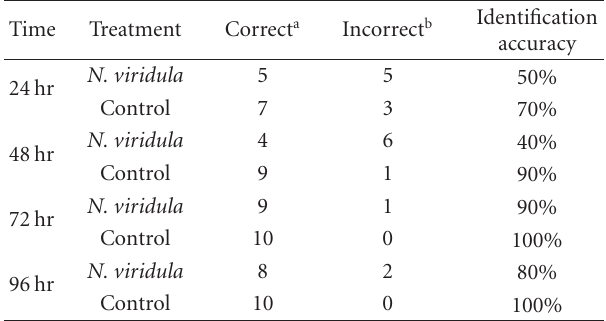
Table 3: Accuracy of E-nose training sets used to identify 10 unexposed bolls (control) and 10 bolls exposed to Nezara viridula collected during a 96 hr feeding trial.